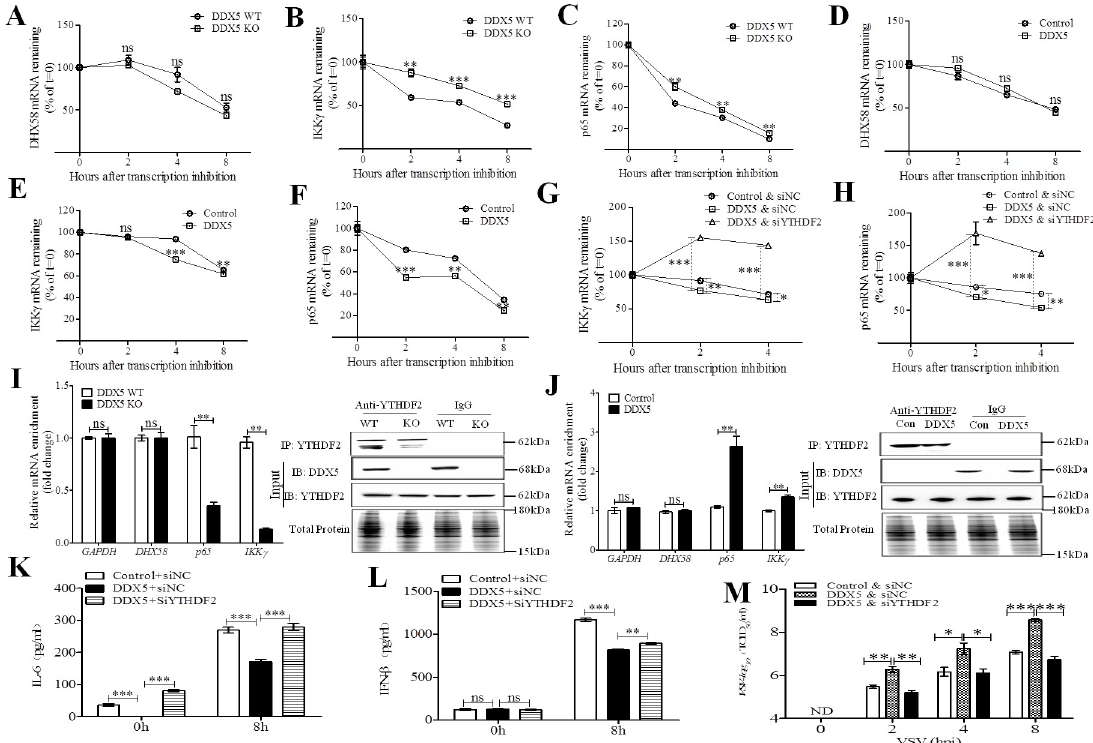
Fig 6. DDX5 inhibited innate immunity through promoting RNA decay of antiviral transcripts in a YTHDF2-dependent manner. (A-C): DHX58, IKK γ , and p65 mRNA degradation in VSV infected DDX5-knockout (KO) MEFs treated with actinomycin D at indicated times (n = 3), the DDX5 wild type (WT) MEFs as the control. Residual RNAs were normalized to 0 h. ( D-F): DHX58, IKK γ , and p65 mRNA degradation in VSV infected DDX5-expressing MEFs treated with actinomycin D at indicated times (n = 3), the DDX5 wild type (WT) MEFs as the control. Residual RNAs were normalized to 0 h. ( G, H): IKK γ and p65 mRNA degradation in indicated YTHDF2-silenced MEFs treated with actinomycin-D (n = 3). Residual RNAs were normalized to 0 h. MEFs were transfected with YTHDF2 siRNA (siNC) for 24h, transfected with DDX5 (control vector) for 24h, infected with VSV, and then treated with actinomycin D at indicated times (n = 3). Residual RNAs were normalized to 0 h. (I, J): The binding of YTHDF2 and transcripts was detected via YTHDF2 RIP qRT-PCR in DDX5 KO (I) or DDX5-expressing (J) MEFs after VSV infection. DDX5 KO MEFs were infected with VSV for 6 h (I), or MEFs were transfected with DDX5 expression plasmid (DDX5) or control vector (Con) for 24 h, then infected with VSV for 6 h (J), next all the treated MEFs were subjected to YTHDF2 RIP qRT-PCR to detect GAPDH, DHX58, IKK γ , and p65. Results are presented relative to those obtained with NC or control groups, and the expression of all the indicated proteins was analyzed by western blotting. (K, L): ELISA of IL-6 or IFN- β in supernatants of YTHDF2-knockdown coupled with DDX5-expressing MEFs infected with VSV for 0 or 8 h. ( M): TCID 50 of VSV in YTHDF2-knockdown coupled with DDX5-expressing MEFs infected with VSV for 0, 2, 4, and 8 h. All data are mean ± SEM of biologically independent samples. n = number of biological replicates. Data are representative of three independent experiments. ND, not detected. ns, no significant difference. � p < 0.05, �� p < 0.01, and ��� p < 0.001 (Student’s t -test).